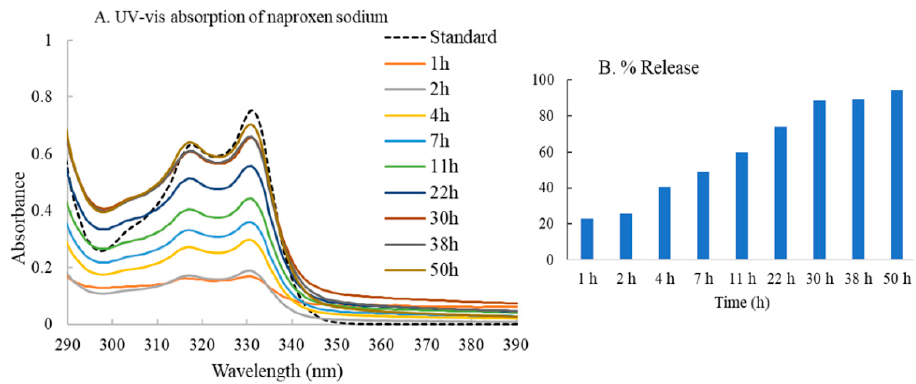
Figure 10. ( A ) UV-vis absorption spectra of naproxen sodium from the aqueous phase added on top of the gel at different times. ( B ) The estimated percent release of the drug from the gel. The absorption at 330 nm was used to calculate the amount of drug released. Formula used: % Drug released = [A solution /A standard ]*100.